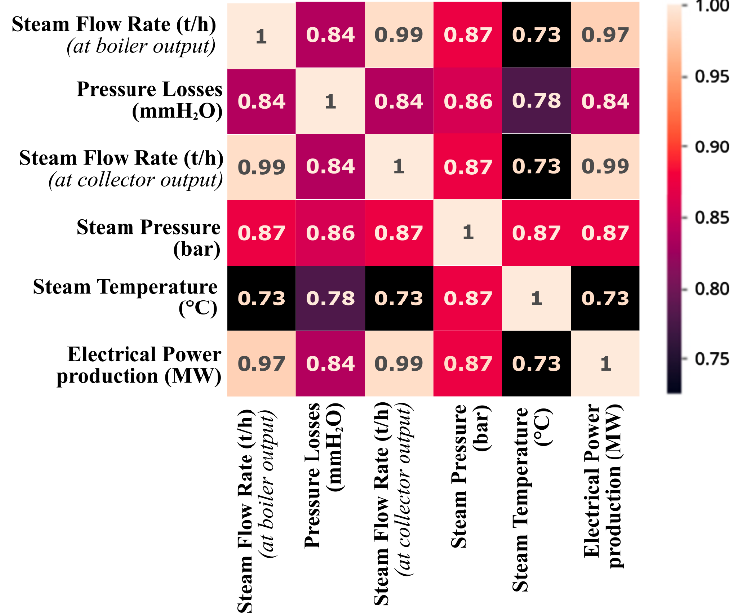
Figure 2. Correlation matrix of studied parameters.